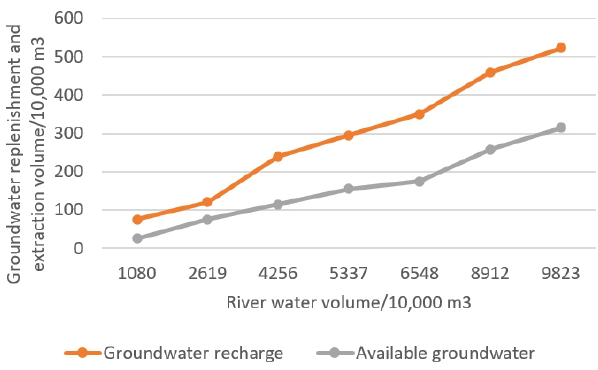
Fig. 1 The relationship between groundwater recharge and extractable